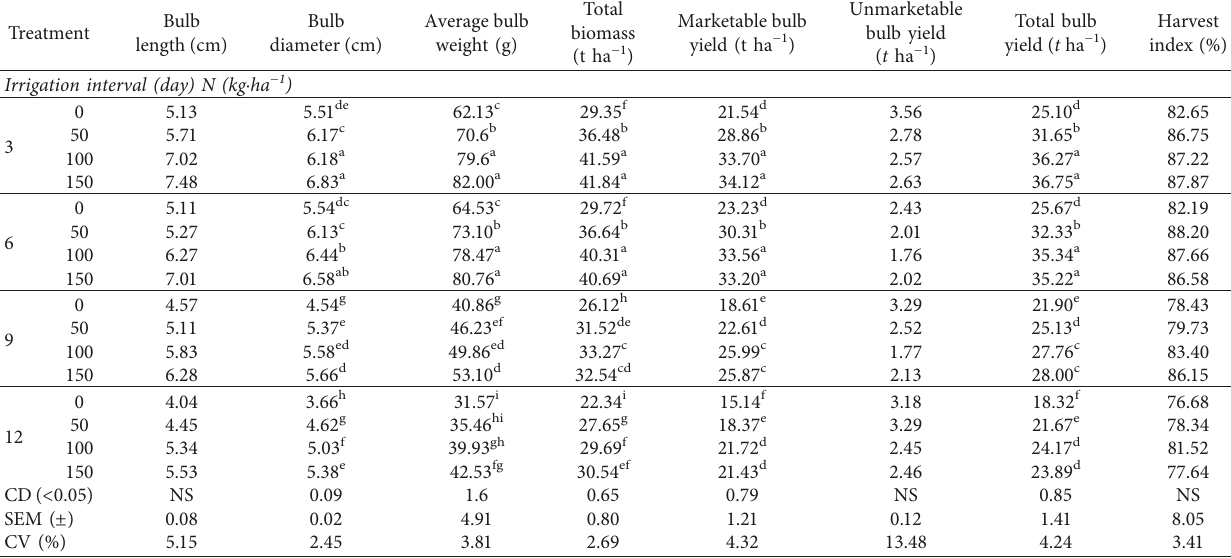
Table 6: Interaction effect of the irrigation interval and N rate on yield and yield components of onion.